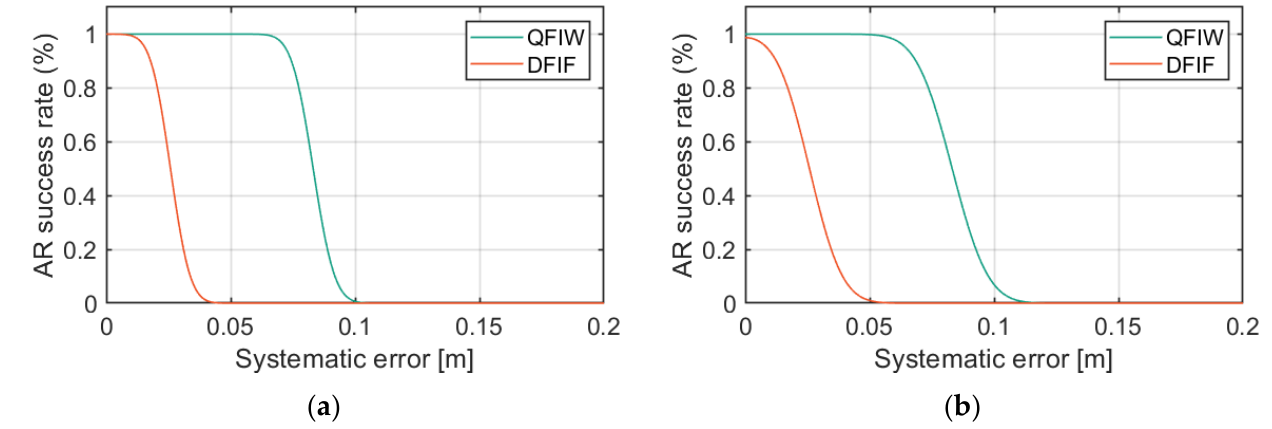
Figure 2. AR (ambiguity resolution) success rates of DFIF (double-frequency ionosphere-free) and QFIW (quad-frequency ionosphere-weighted) models under different system errors and phase errors: ( a , b ).